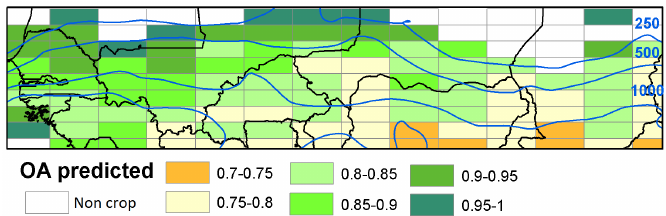
Figure 16. Prediction of OA over the study area based on a multiple regression using eight explanatory variables related to spatial localization, data availability and landscape